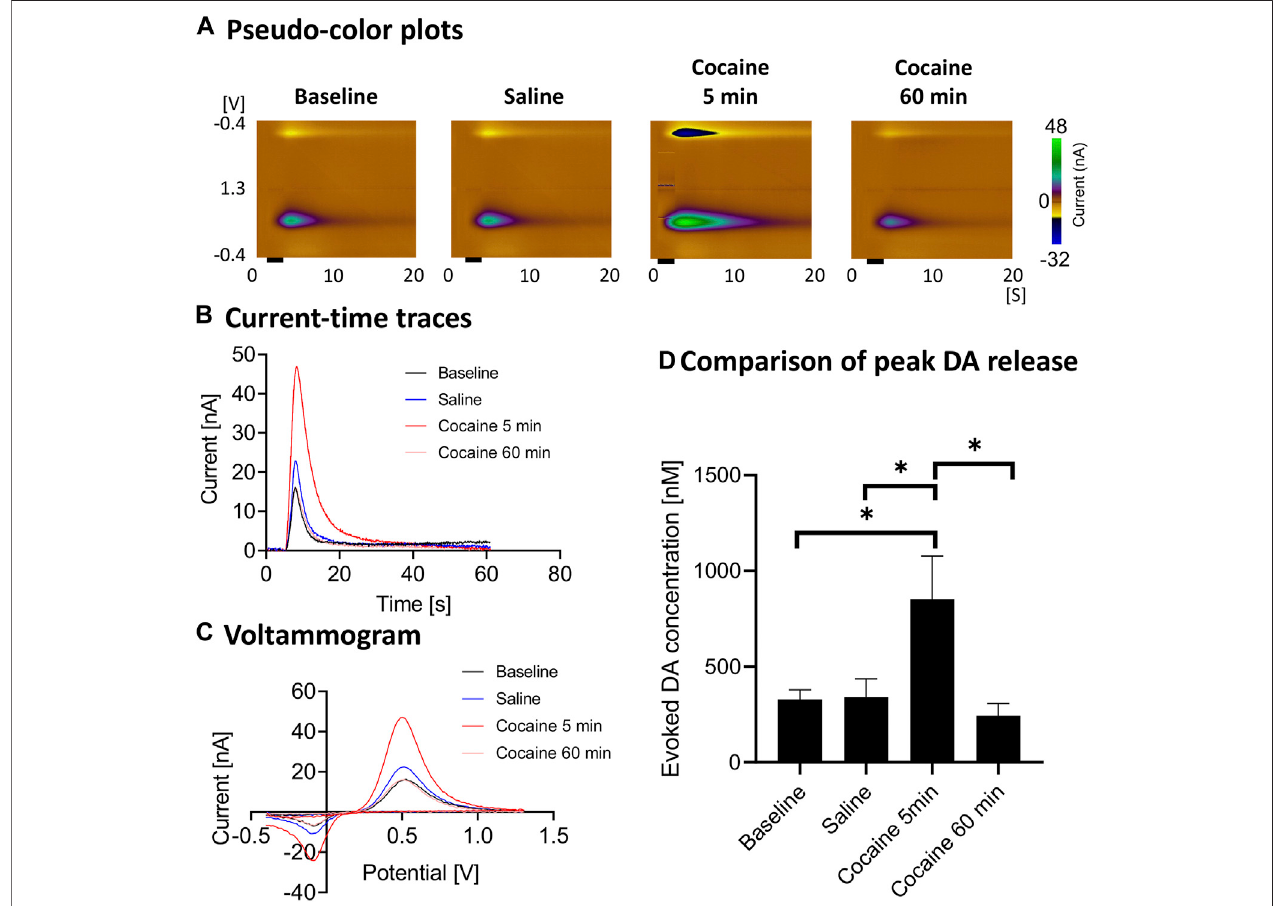
FIGURE2| Peakandgradualdecayofcocaine-inducedchangesinstimulation-evokeddopaminerelease. Invivo FSCVmeasurementsinthenucleusaccumbens core showing augmented dopamine responses to cocaine injection (3 mg/kg, i.v.). Responses were measured following medial forebrain bundle stimulation (2 s, biphasic, 300 μ A, 2 ms pulse width). (A) Representative pseudo-color plots pre- and post-cocaine injection, (B) Oxidative current-time traces, (C) Voltammograms (at the peak) and (D) Maximum change in dopamine concentration with medial forebrain bundle stimulation at different time points ( n (cid:1) 4 rats). Black bar represents electrical stimulation (2 s). *denotes p < 0.05. n (cid:1) 4 rats. DA ,